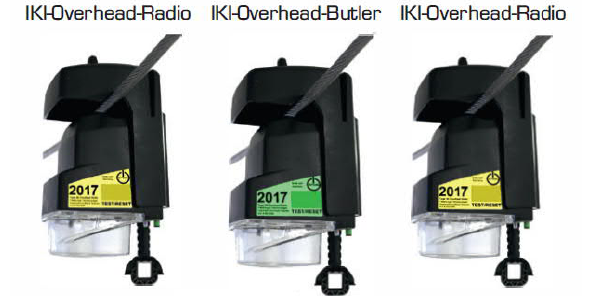
Fig. 3. IKI-Overhead fault indicators